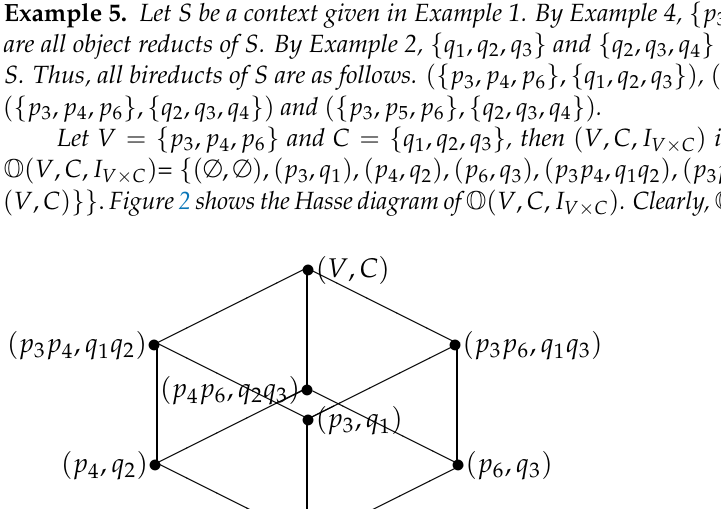
Figure 2: The Hasse diagram of O ( V , C , I The bireduction process is as